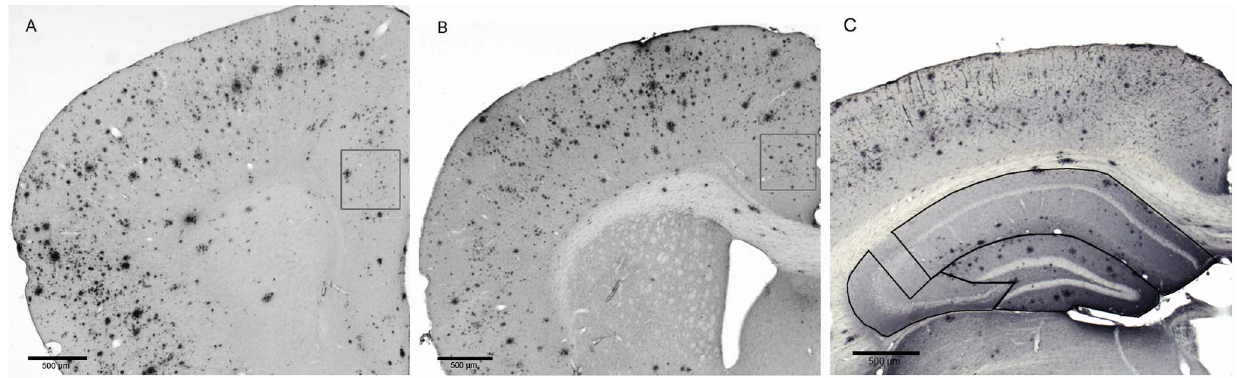
Figure 4. Representative images of the amyloid- b plaque load in the brain of a 12-month-old A b PP-PS1 mouse. A: The A b plaque load was quantified in the prelimbic area at level + 1.98 up to + 1.78 anterior to bregma, B: in the anterior cingulate gyrus at level + 1.10 up to + 0.86 anterior to bregma, and C: in the dentate gyrus (DG), CA1 and CA3 areas of the hippocampus at level 2 2.18 up to 2 2.46 posterior to bregma, using one appropriate section per animal. Images were taken using a 2.5 6 objective. Scale bar=500 m